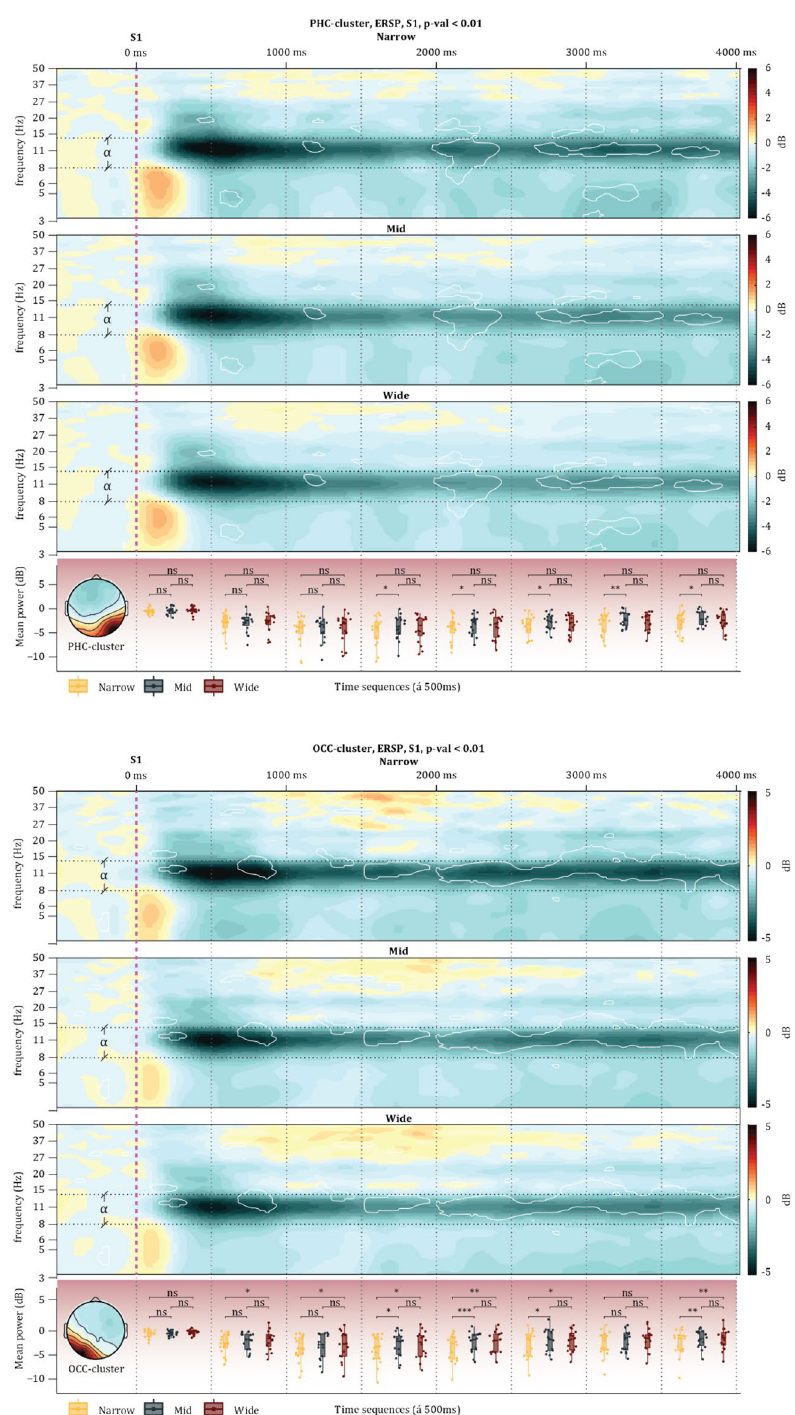
Figure 6. The panel above displays the ERSPs for each condition in the PHC-cluster (above) and the OCC- cluster (below) during the immobile phase. The overlayed white lines represent the areas with a significant difference according to the permutation tests (1,000 permutations). The vertical magenta dashed line represents the onset of the stimulus (Lights On), while the vertical dotted black lines represent the time sequence (500 ms per sequence) that alpha power values were separated into and analysed by way of ANOVA and Tukey HSD. Horizontal black dashed lines represent the range of the alpha frequency. The bottom panel illustrates the Tukey HSD results; all p > .05 are written as ‘ns’, all p < .05 are written *, all p < .01 are written **, and all p < .001 are written